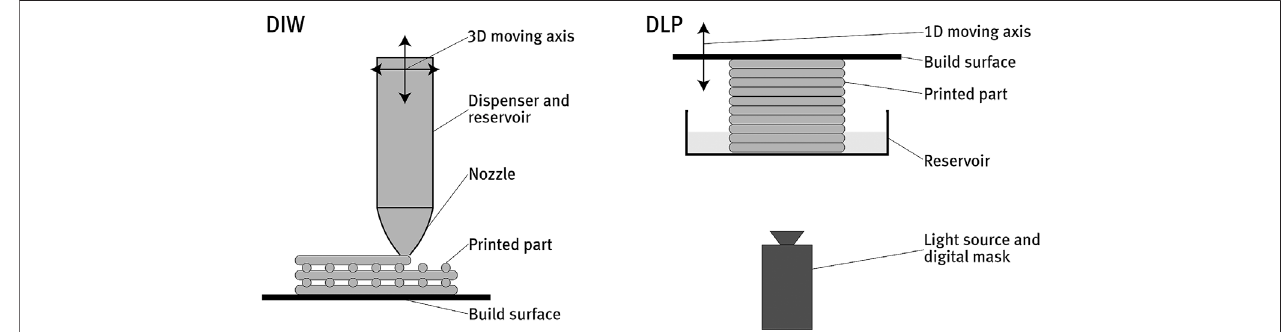
FIGURE 5 | Schematic illustration of additive manufacturing by DIW (left) and DLP (right).